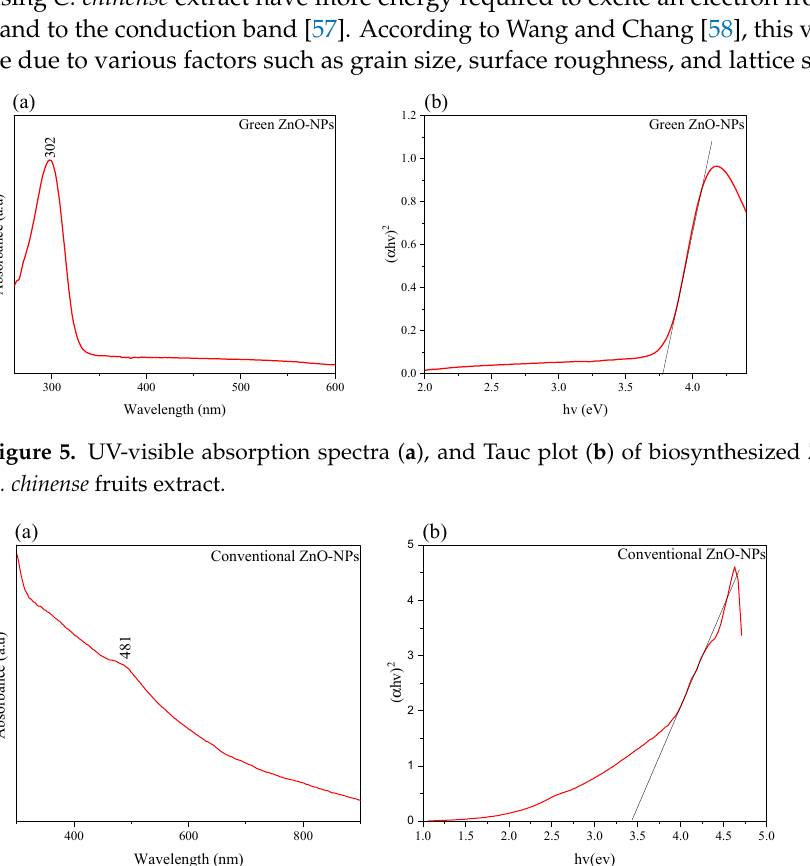
Figure 6. UV-visible absorption spectra ( a ), and Tauc plot ( b ) of ZnO-NPs synthesized without C. chinense fruits extract.